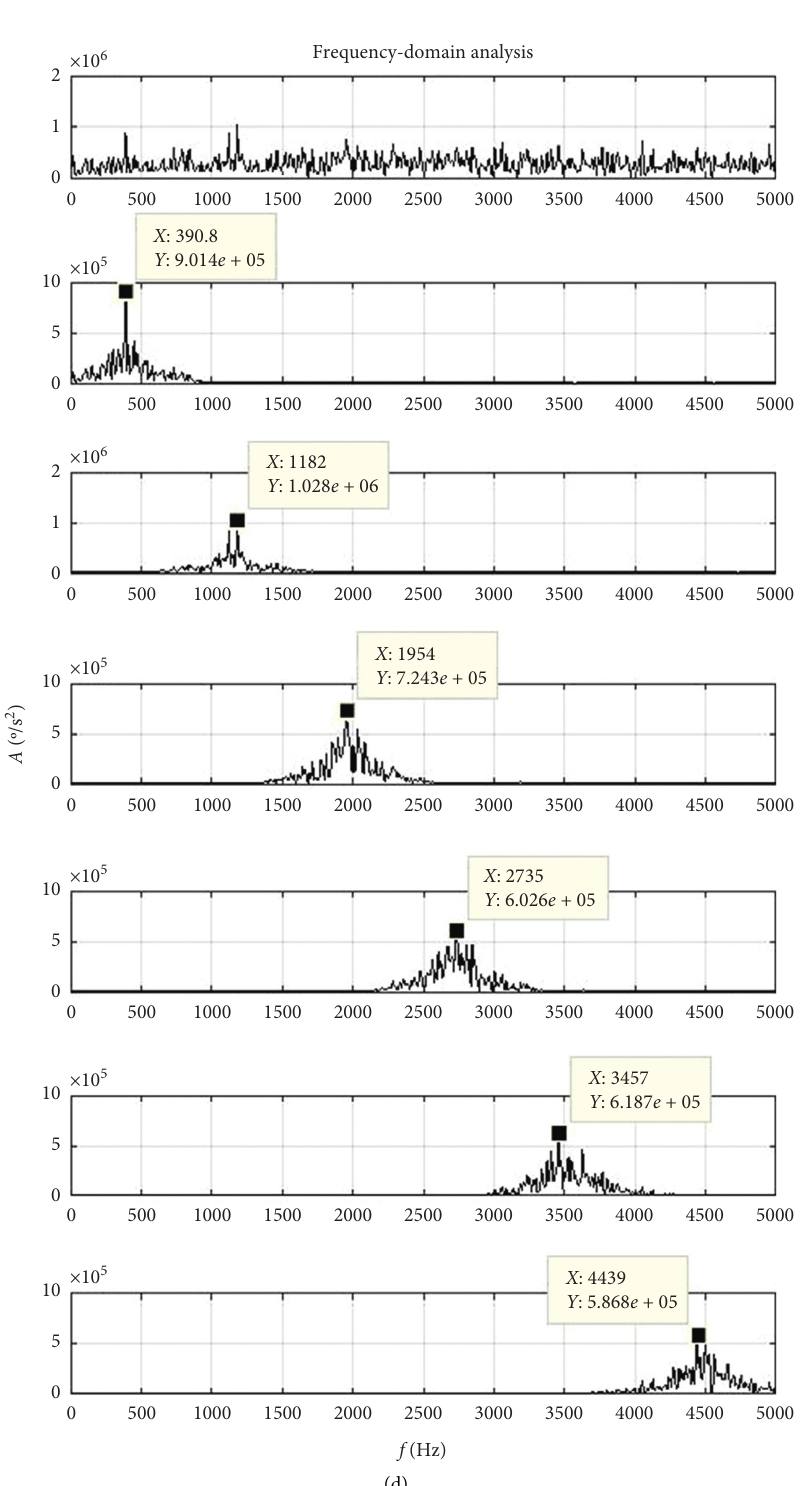
Figure 11: Each IMF of angular acceleration signal for no crack and 1 # to 3 # crack. (a) No crack. (b) 1 # crack. (c) 2 # crack. (d) 3 #